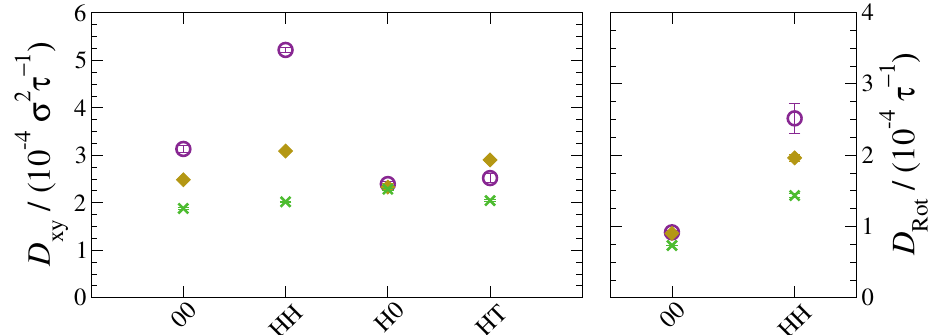
Figure 10. Translational diffusivity of NDs in the plane (left) and rotational diffusivity (right) for various particle mass fractions: 1wt% (purple empty circles), 5wt% (yellow full diamonds) and 10wt% (green